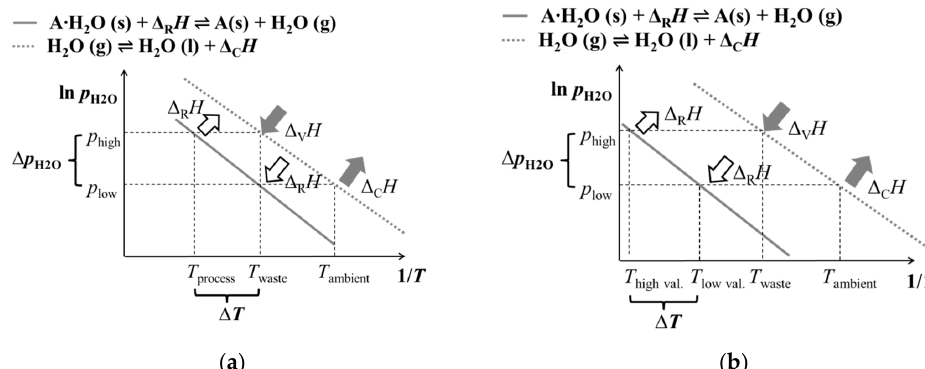
Figure 1. Van’t Hoff diagrams of generic water vapor-solid reactions combined with the vapor–liquid equilibrium of the gaseous reactant. Depending on the chosen gas–solid working pair, two modes of operation are possible: ( a ) thermal upgrade of low temperature waste heat ( T waste to T process ) and ( b ) thermal upgrade of high-temperature process heat ( T low val. to T high val. ) driven by low-temperature waste heat (operation concept of this work).